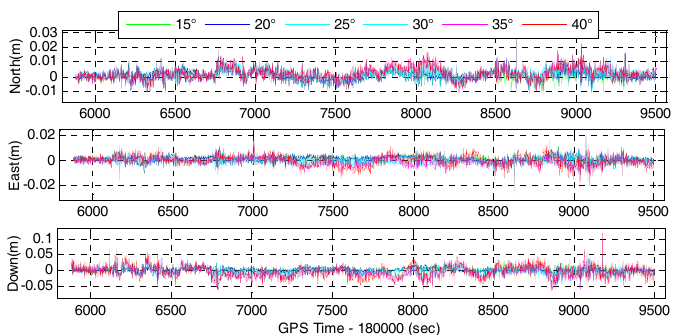
Figure 11. Position difference of GPS/BDS RTK for elevation cut-off angles of 15, 20, 25, 30, 35 and 40°.